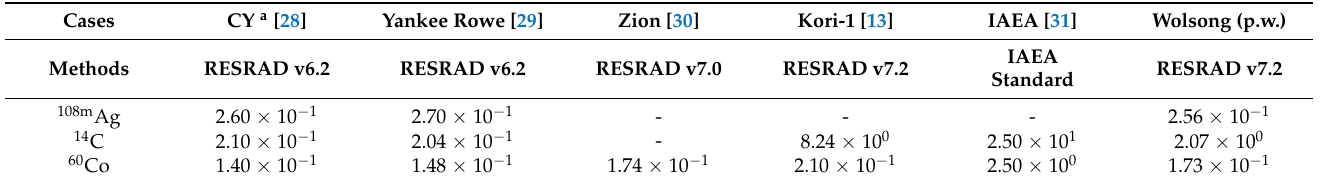
Table 5. Comparison of DCGL results (Bq · g − 1 ) for various radionuclides derived with a regulatory dose limit of 0.25 mSv · year − 1